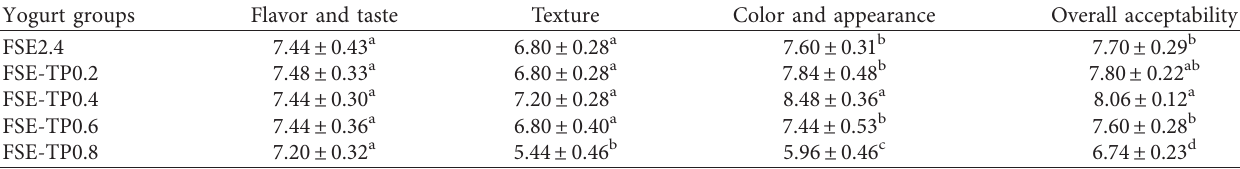
FSE:Flos Sophorae extract;TP: Tremella fuciformis polysaccharides;Con:theyogurt withoutFSEor TP;basedon2.4% FSE,thedifferent concentrationsofTP (0, 0.2, 0.4, 0.6, and 0.8mg/mL milk) were added to produce FSE2.4, FSE-TP0.2, FSE-TP0.4, FSE-TP0.6, and FSE-TP0.8 yogurts. In each column, the values with different letters indicated significant differences among groups ( p < 0 .